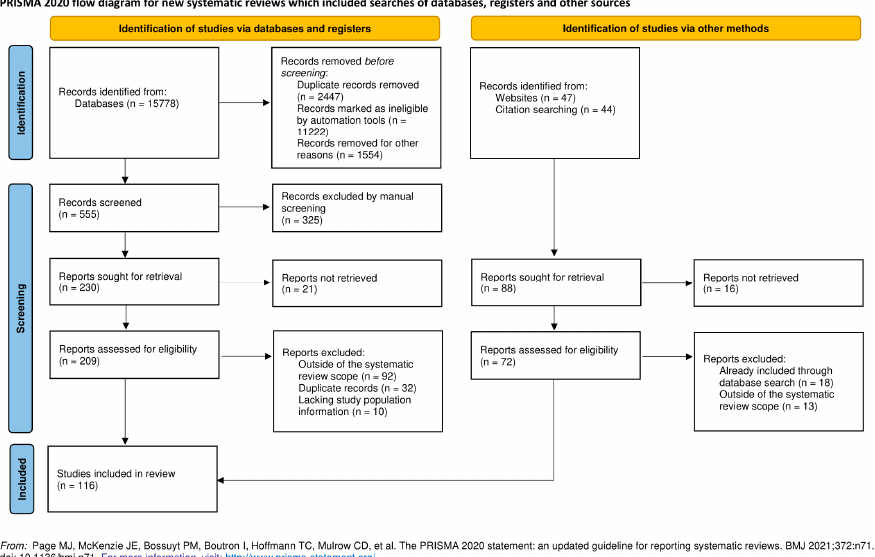
Figure 1. Prisma flow diagram for the systematic review [117].